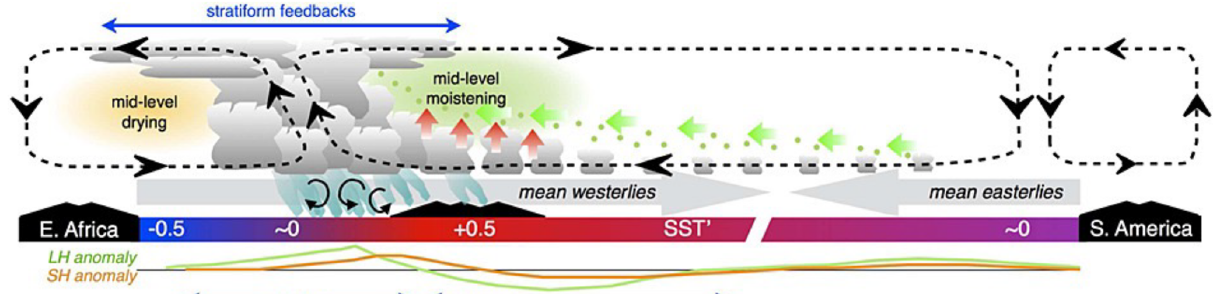
Figure 6. Schematic depiction of Indian Ocean and Pacific Ocean feedbacks to the MJO when convection (grey cloud elements) is maximized in the eastern Indian Ocean. Rainfall (aquamarine), circulation anomalies (dashed black cells), convective downdrafts (black rotor arrows), mean winds (faint grey arrows), moistening by convective detrainment (small green dots), and horizontal and vertical advection (thick green and red arrows, respectively) are overlaid. Net moistening (drying) is shaded green (orange). Positive (red) and negative (blue) SST anomalies for a strong event are shaded, while latent (sensible) heat flux anomalies are shown with green (orange) curves. The central and eastern Pacific spatial scales are compressed relative to the Pacific Warm Pool. Adapted from DeMott et al.